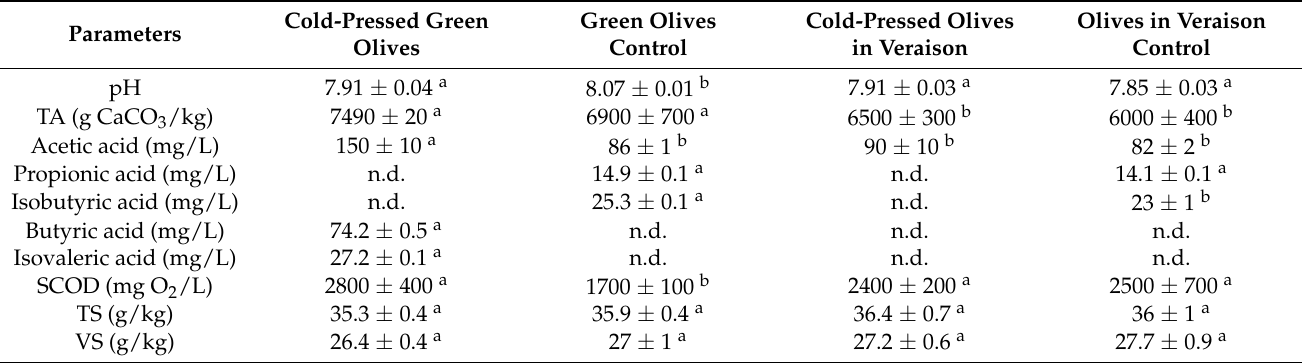
Table 3. Principal characteristics of the four digestates or anaerobic effluents resulting from the BMP experiments of the mixture residues tested. Values represent means ± standard deviations. Different superscripted letters (a, b) mean values are significantly different. n.d.: not determined.